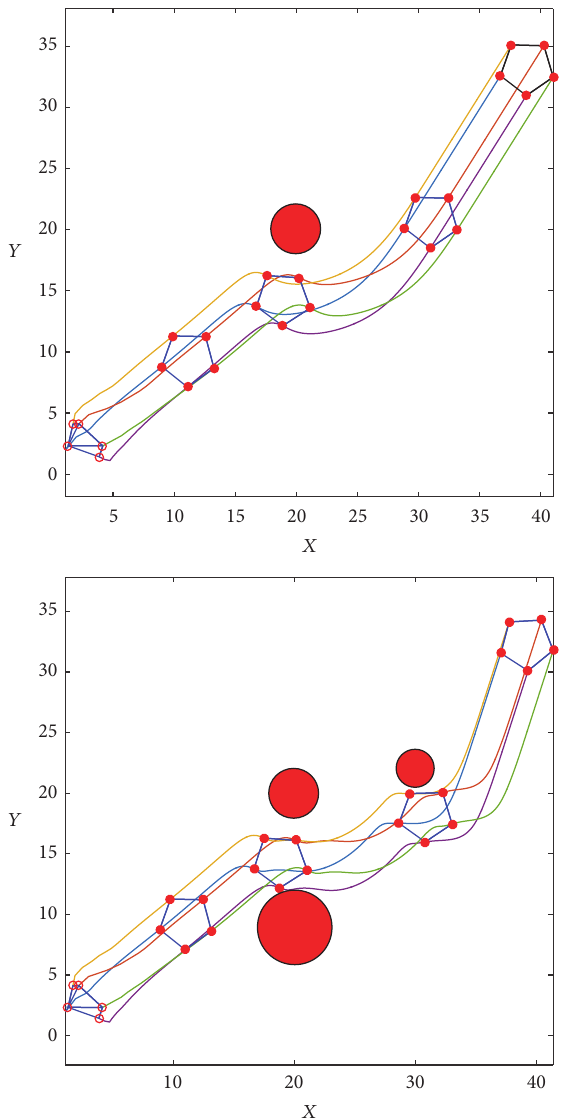
Figure 11: Multiagent robot trajectories with single and multiple obstacles with algebraic connectivity